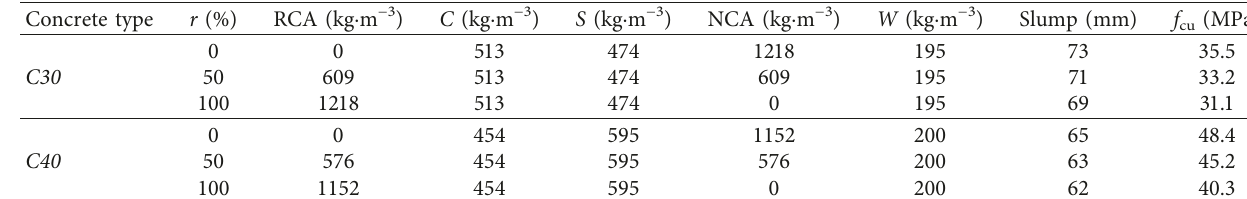
Table 1: Mix proportion of the recycled coarse aggregate concrete.